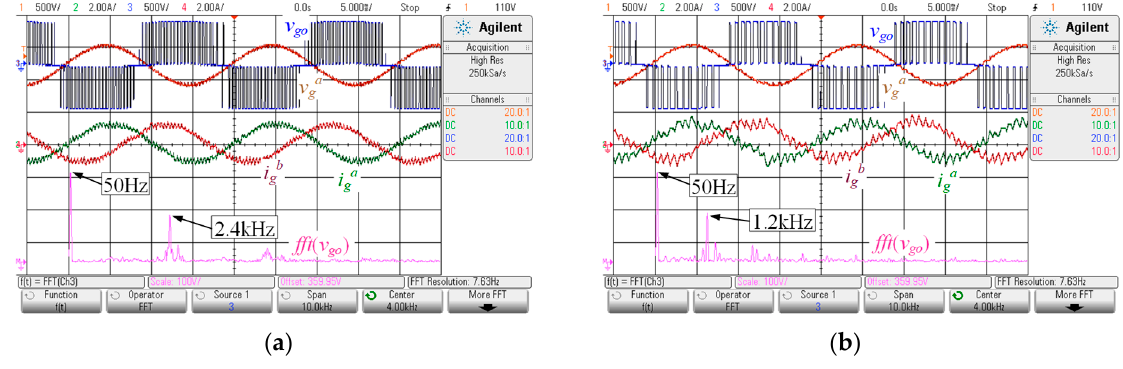
Figure 9. Frequency response ( a ) N = 48, i.e., f s = 2.4 kHz, ( b ) N = 24, i.e., f s = 1.2 kHz.